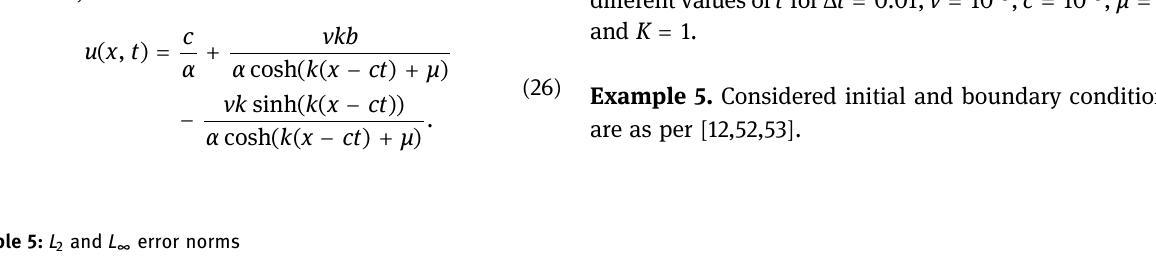
Figure 4, graphical comparison of solutions is given at di ff erent values of t for